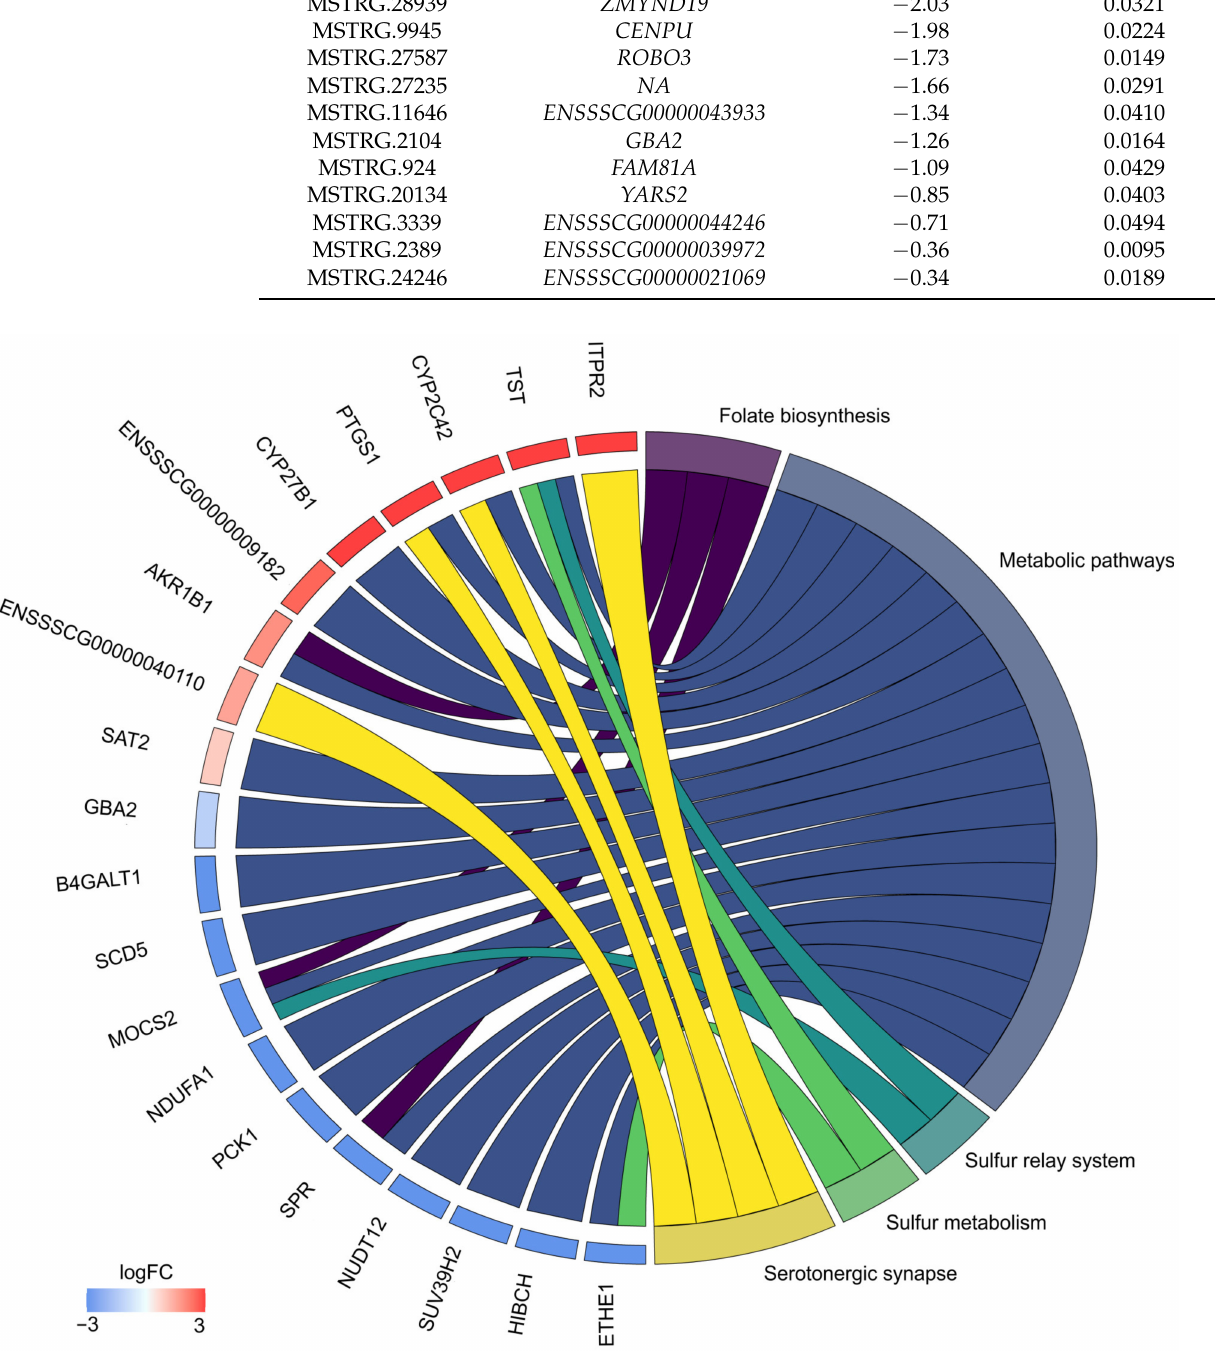
Figure 3. Circos plot representing five significantly enriched Kyoto Encyclopedia of Genes and Genomes (KEGG) pathways associated with differentially expressed genes (DEGs) that altered due to resiniferatoxin (RTX) intravesical administration. Gene symbols with logarithmic values (blue–red scale) of fold change (logFC) are located on the left side of the circos. Five color links merge genes with KEGG annotations (‘Folate biosynthesis’, ‘Metabolic pathways’, ‘Sulfur relay system’, ‘Sulfur metabolism’, and ‘Serotonergic synapse’) on the right